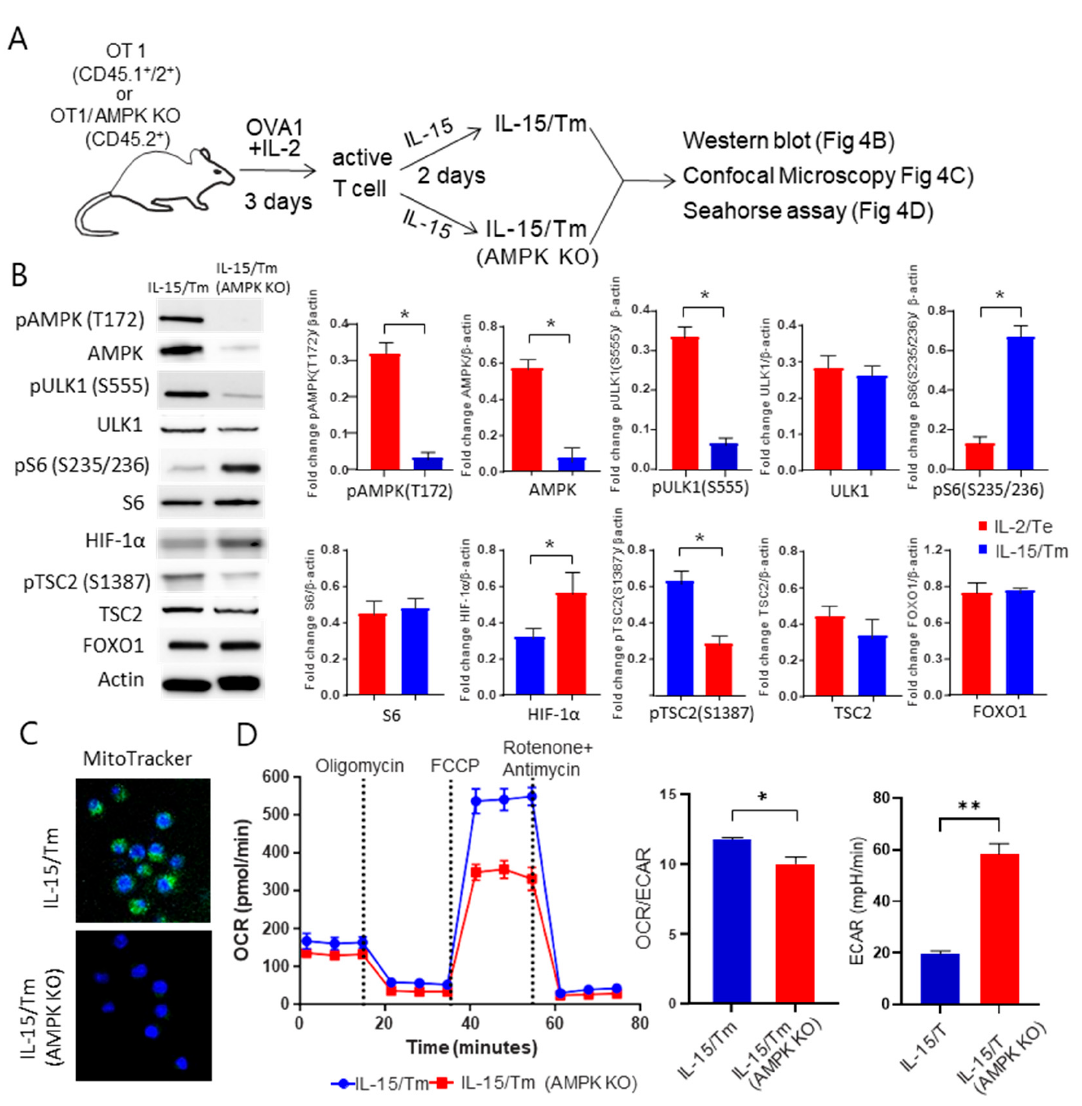
Figure 4. Characterization of in vitro prepared WT IL-15/T M and IL-15/T M AMPK α 1 KO cells. ( A ) Schematic diagram of the experimental design for in vitro culture of WT and AMPK α 1 KO IL-15/T M analyzed by Western blotting, confocal microscopy and Seahorse assays. ( B ) The abundance of proteins of interest in WT and AMPK α 1 KO IL-15/T M cells. Bar graphs represent the fold change in a given protein normalized to β -actin levels. ( C ) WT and AMPK α 1 KO IL-15/T M cells were stained with Mitotracker Mitotracker and imaged by confocal microscopy to visualize mitochondria (green). Magnification, 100×. The nuclei are Hoechst stained (blue). ( D ) Seahorse assay analysis was performed to measure ECAR, OCR and the OCR/ECAR ratio under basal conditions or in response to applying various mitochondrial inhibitors in WT and AMPK α 1 KO IL-15/T M cells, respectively. All data representing one of two independent experiments are presented as means ± SD ( n = 3/group). * p < 0.05, ** p < 0.01 by two-tailed Student t test.